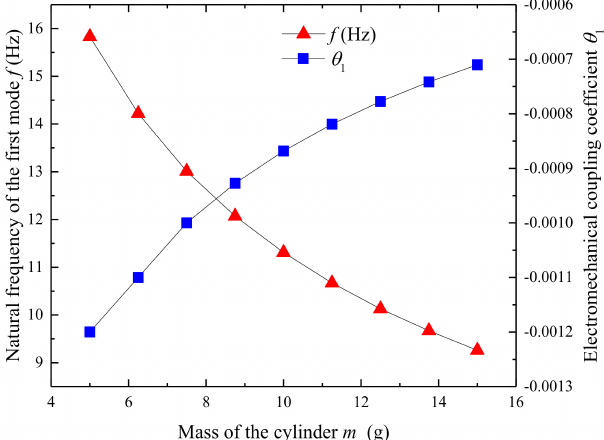
Figure 5. Influence of cylinder mass on the first mode frequency and electromechanical coupling coefficient.